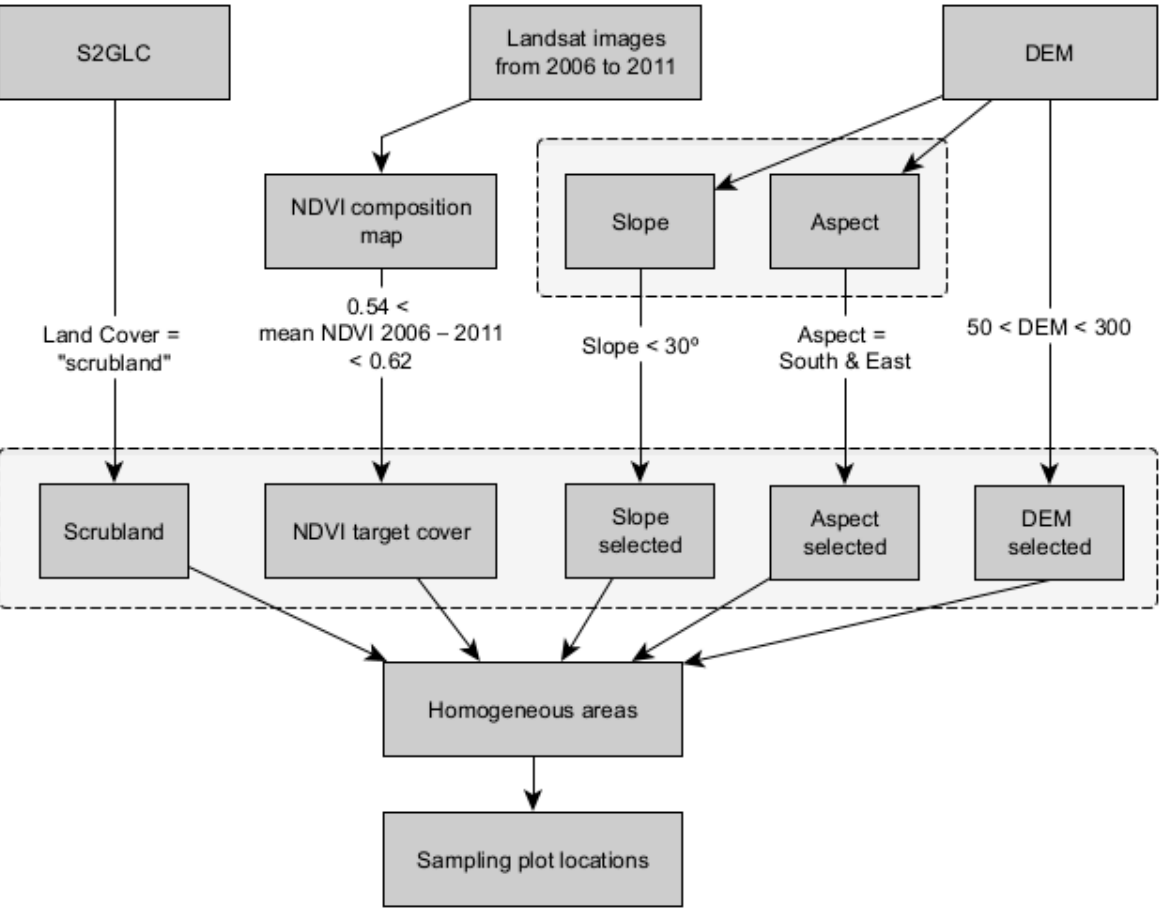
Figure 3. Workflow of spatial criteria to select fifty-four 30 × 30 m 2 plots (29 in treatment zone and 25 in the control zone represented by pink dots in Figure 4) to compare NDVI time series.